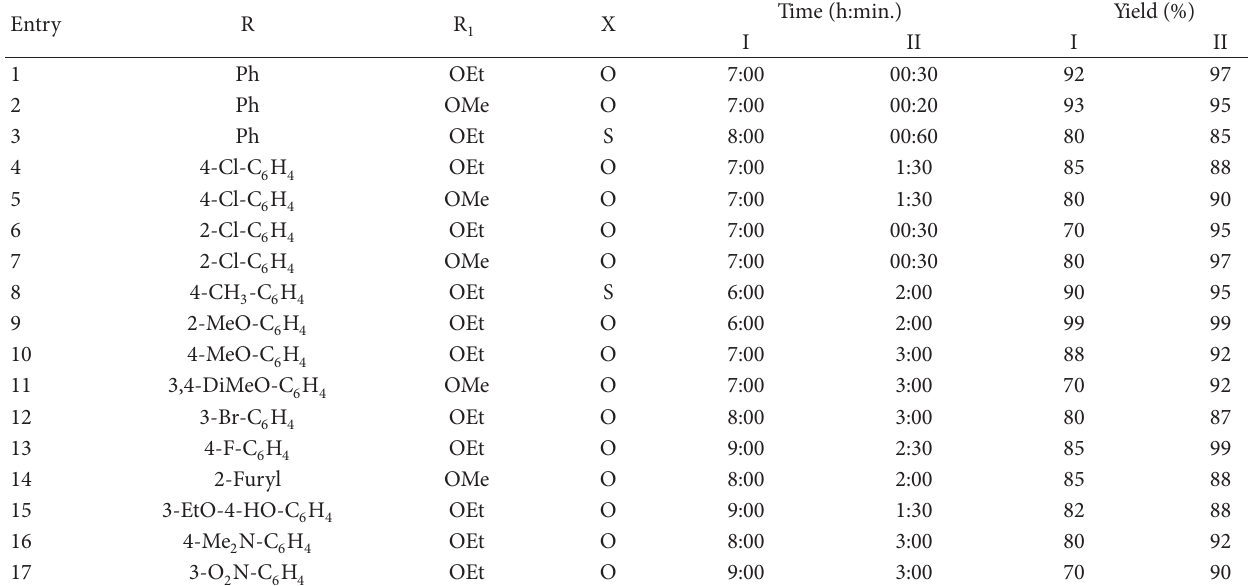
T 4: Synthesis of various dihydropyrimidinones catalyzed by Al (NO